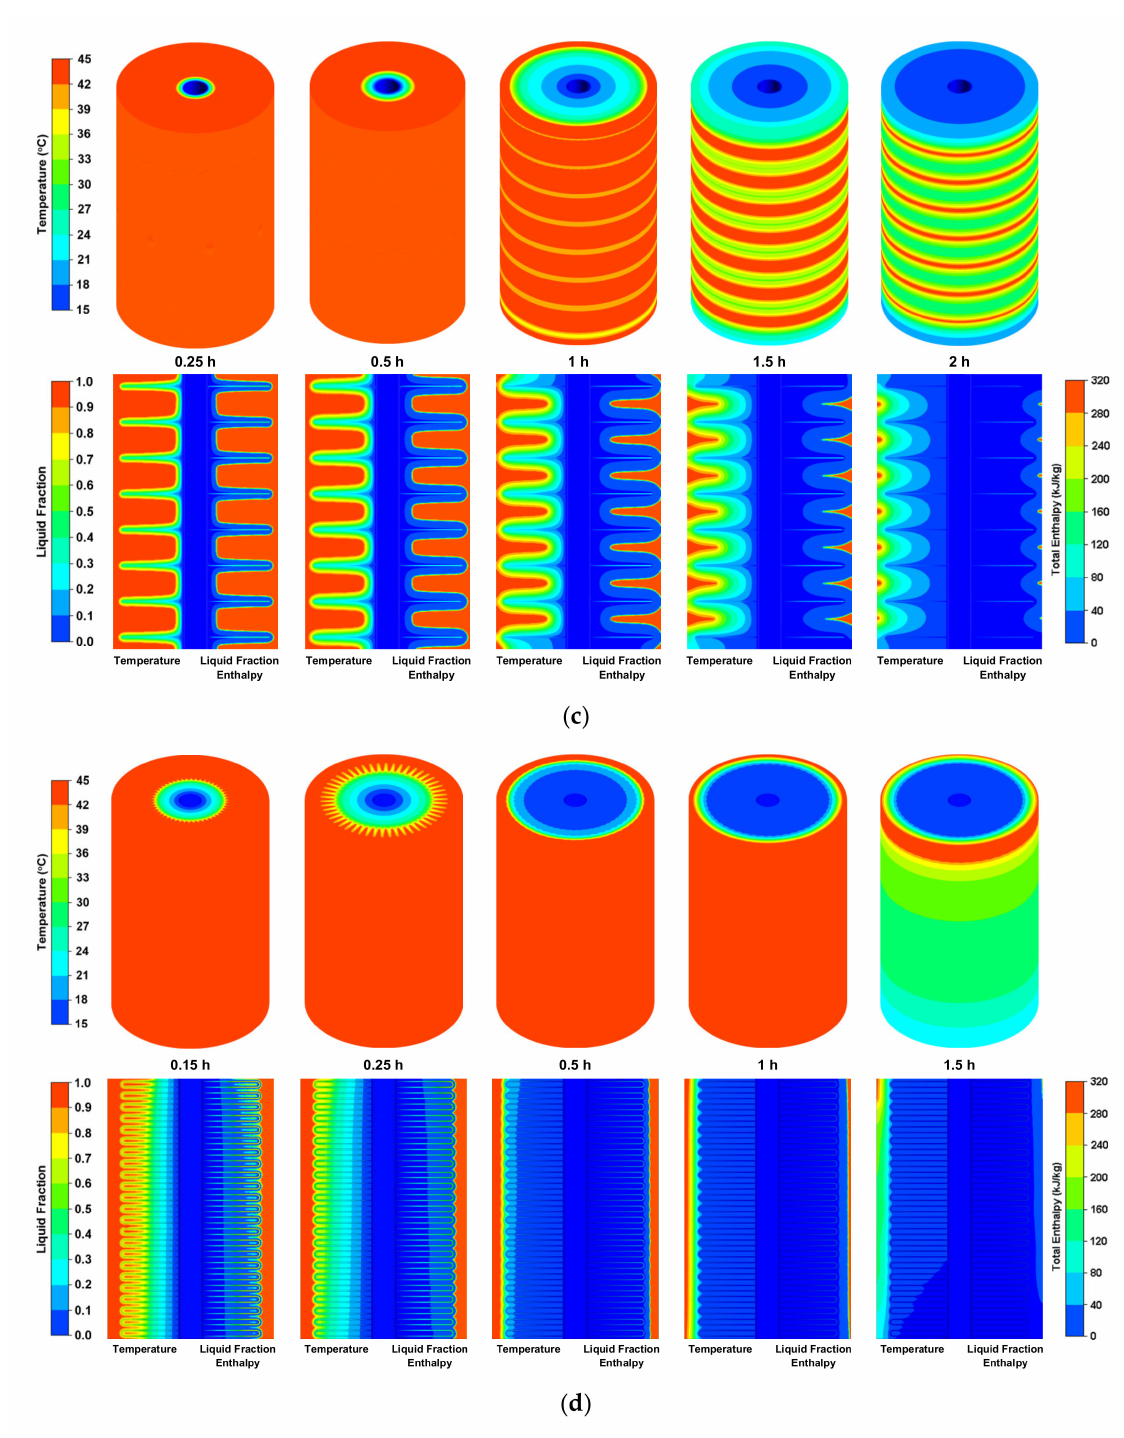
Figure 4. Temperature, total enthalpy and liquid fraction behaviour while discharging in the shell-and-tube with: ( a ) 2.5% GNP and no-fins (case 2), ( b ) longitudinal fins (case 3), ( c ) radial fins (case 4) and ( d ) wire-wound fins (case